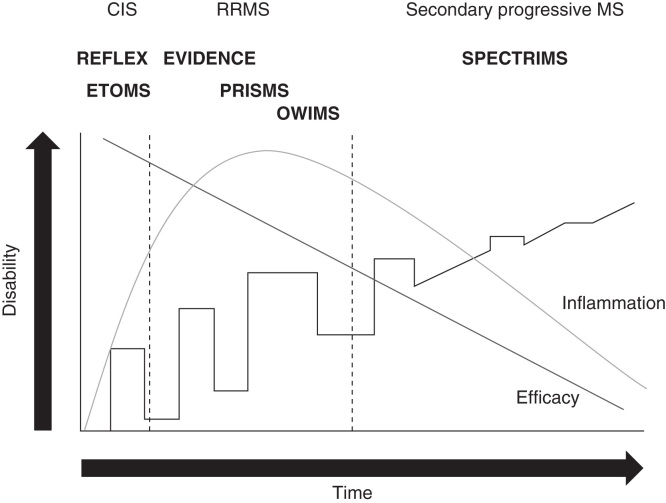

Timeline of theoretical disease course of MS. Response to s.c. IFN-β-1a diminishes when administered later in the disease course.